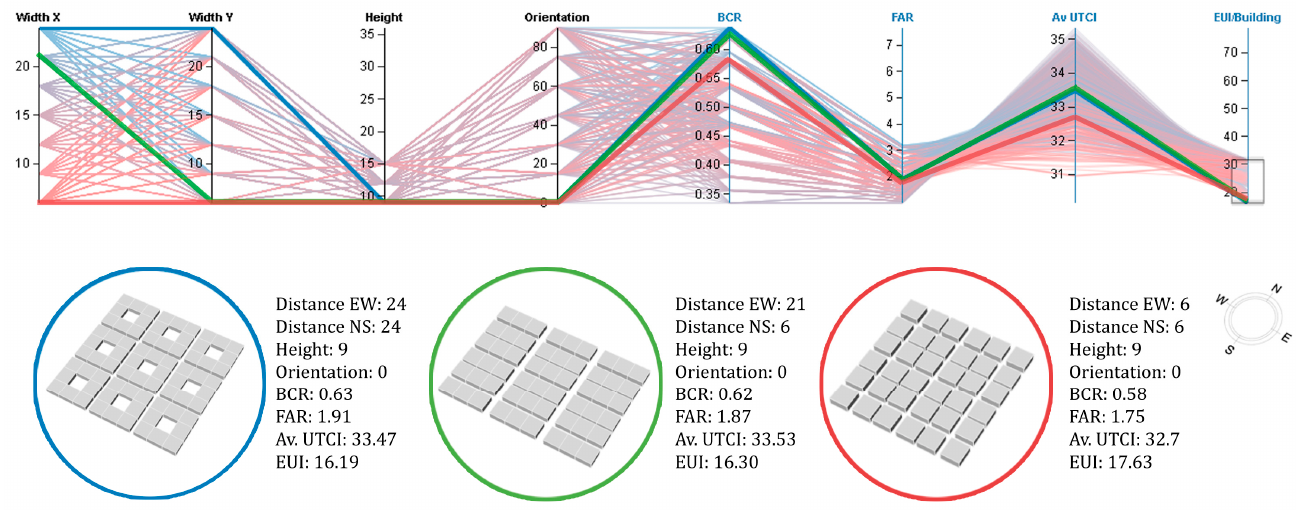
Figure 11. Parallel coordinates showing the selective cases for the minimum EUI.